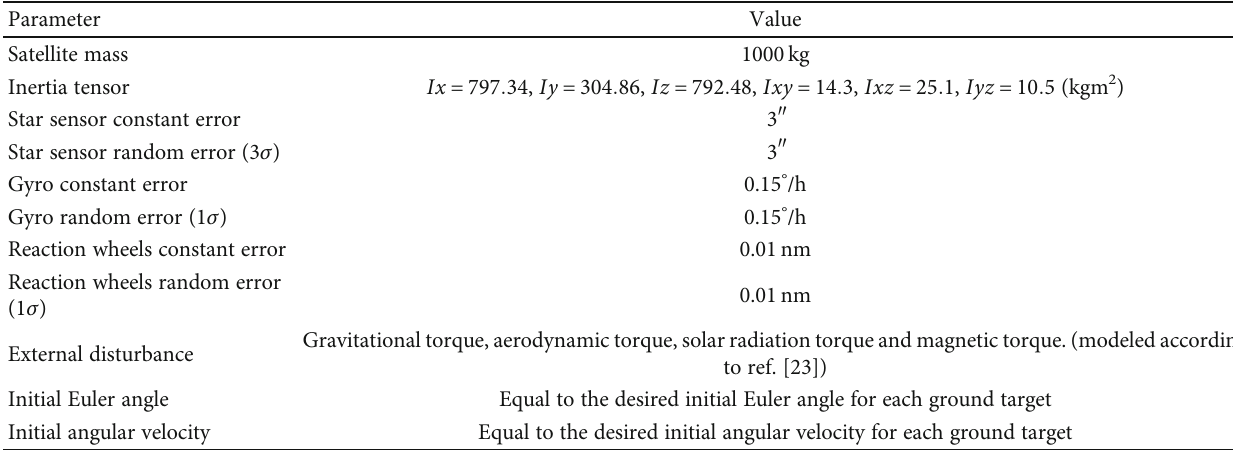
Table 6: Other simulation parameters.